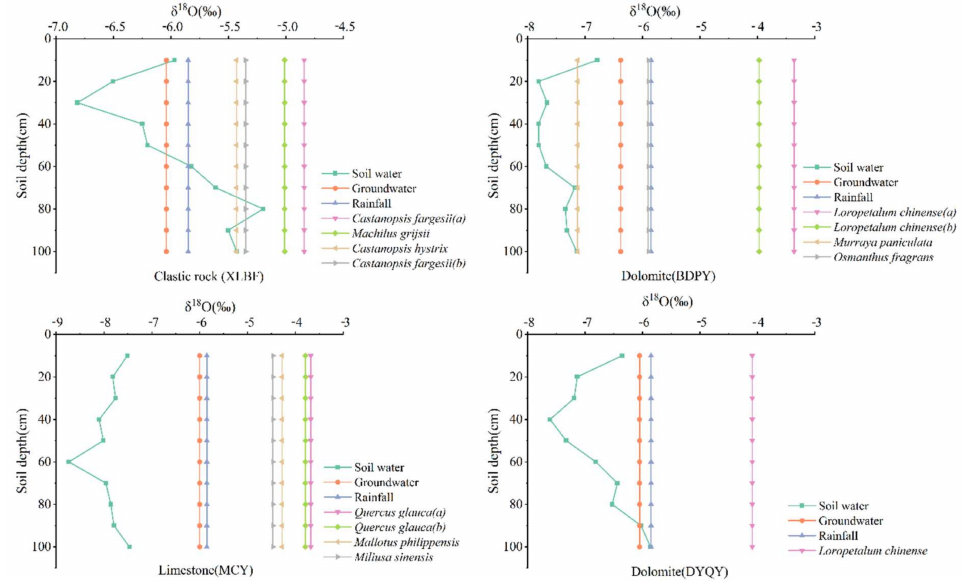
Figure 6. The variation in stem water and soil water δ 18